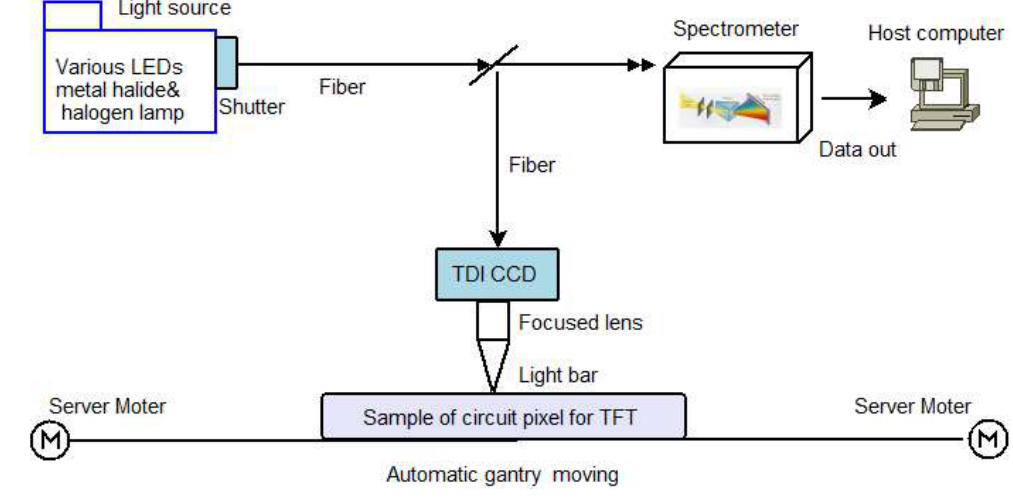
Figure 1. Scanning mode of AOI architecture.